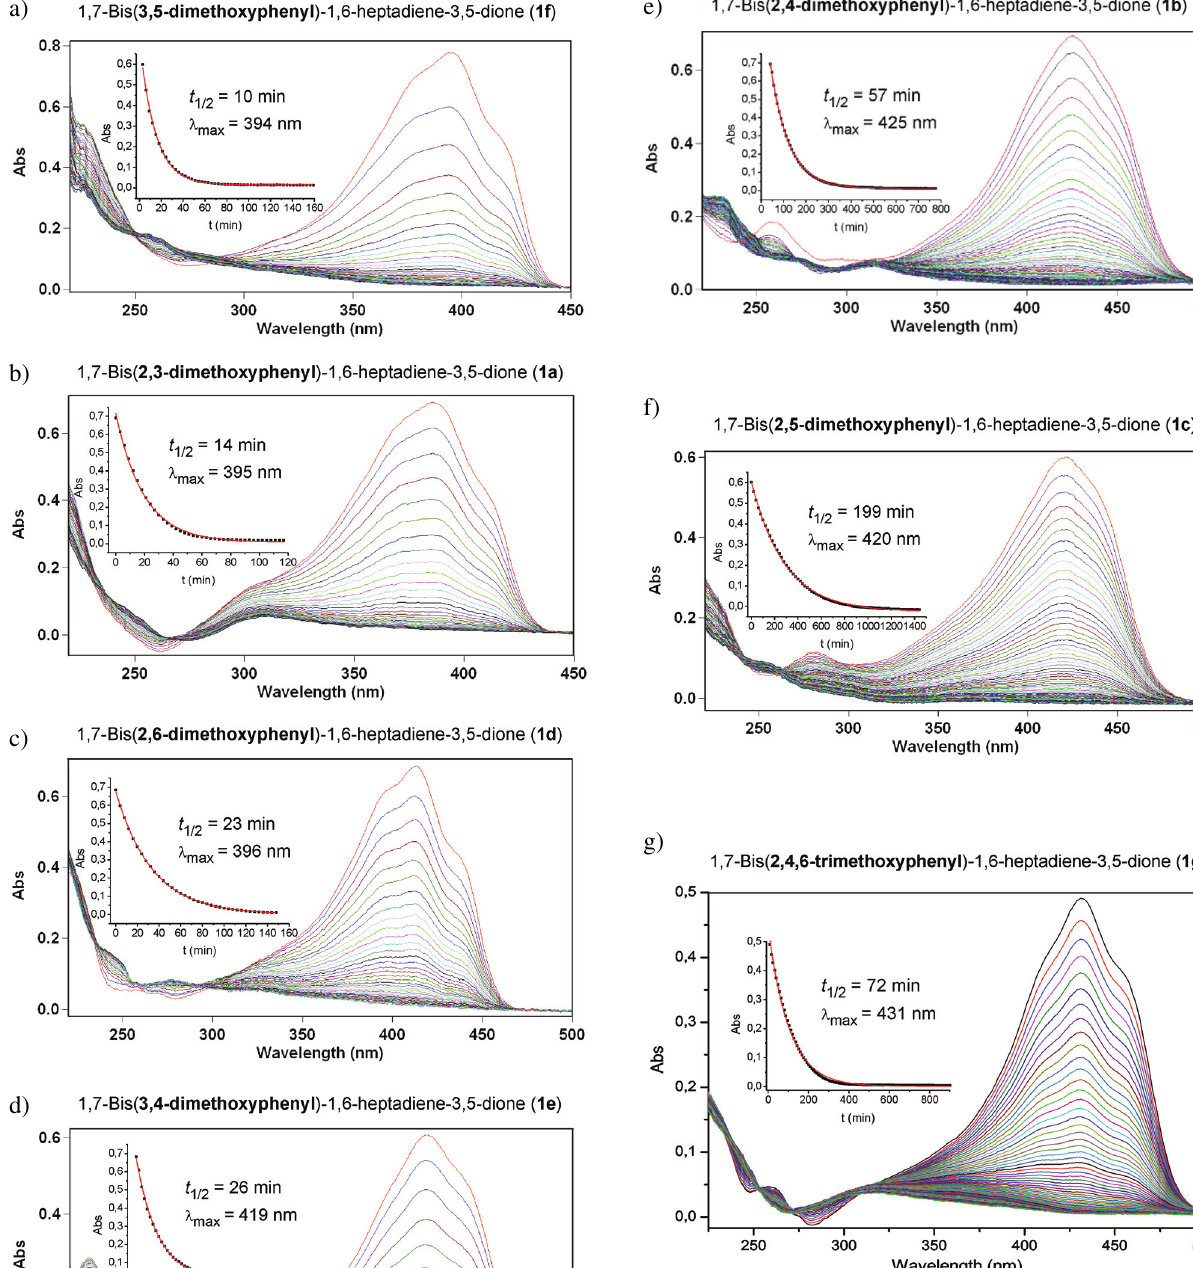
Figure 2. Time-dependent decay profiles of the absorbance of 1.5 × 10 –5 M acetonitrile solutions of methoxy substituted curcumi-